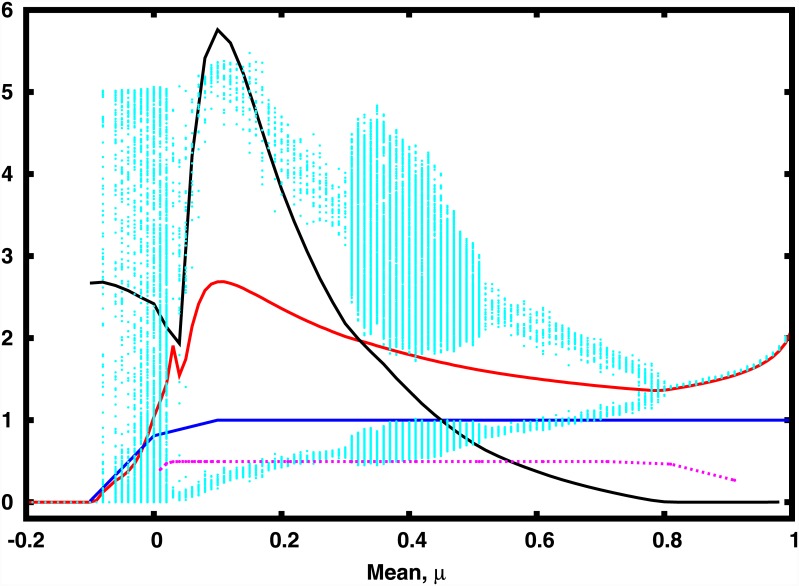
Synchronization error (dotted black), total population (red), bifurcation diagram for the emergent behavior of the population densities (cyan), the average number of active nodes (blue) and phase order parameter, Z
phase (magenta), as a function of mean μ of the interaction strengths.Here the connectivity matrix J has C = 1, σ = 0.1 and the size of network is N = 100. Note that the number of active nodes alone does not determine the total population, as a species can be active and yet persist at very low population densities.